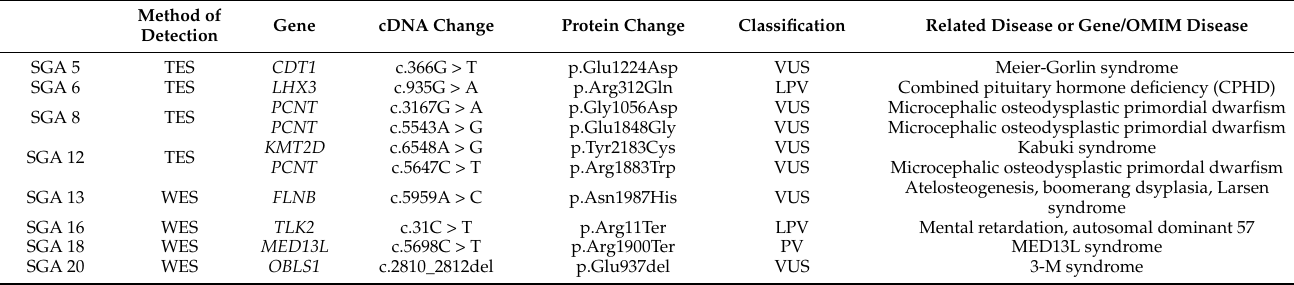
Table 2. Mutations detected in